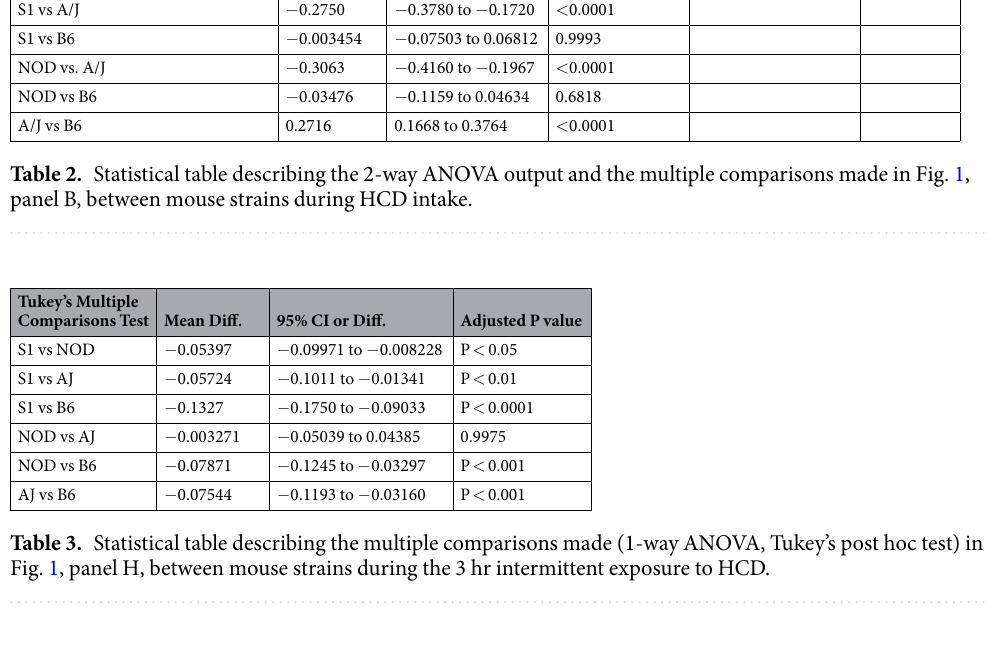
Tukey’s multiple comparison’s test Mean Diff.